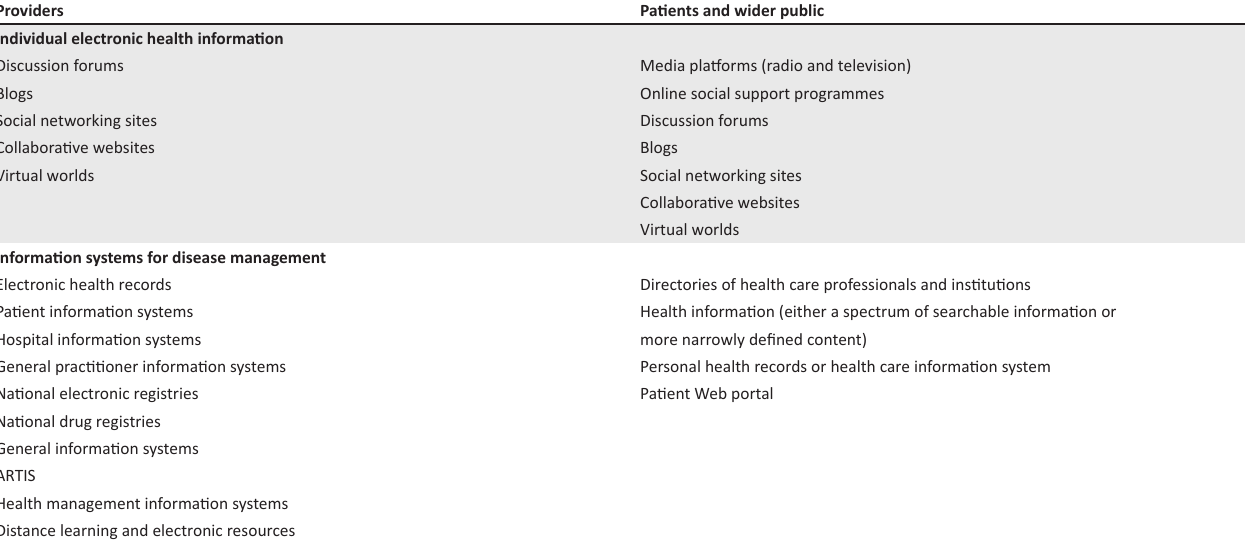
TABLE 2: Information system for health care providers and consumers.